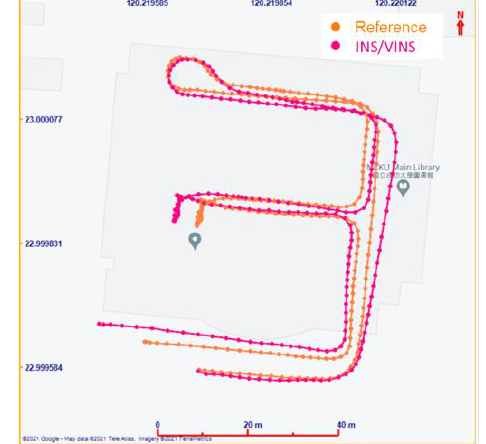
Figure 13. The trajectory of INS/VINS integration method